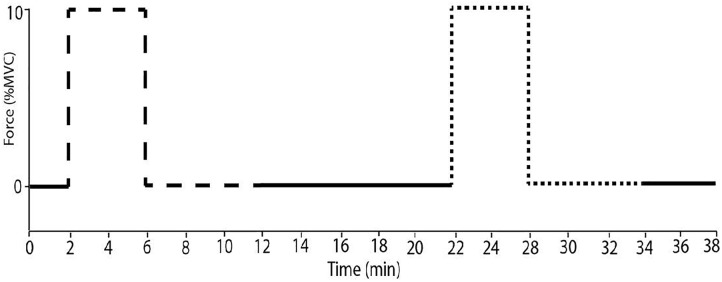
The experimental protocol. Subjects performed sustained ischaemic handgrip (dashed line) for 4 min at 10% MVC with ischaemia imposed for 6 min after contraction. Sustained dorsiflexion (dotted line) was performed under the same conditions with a minimum of 10 min of rest.